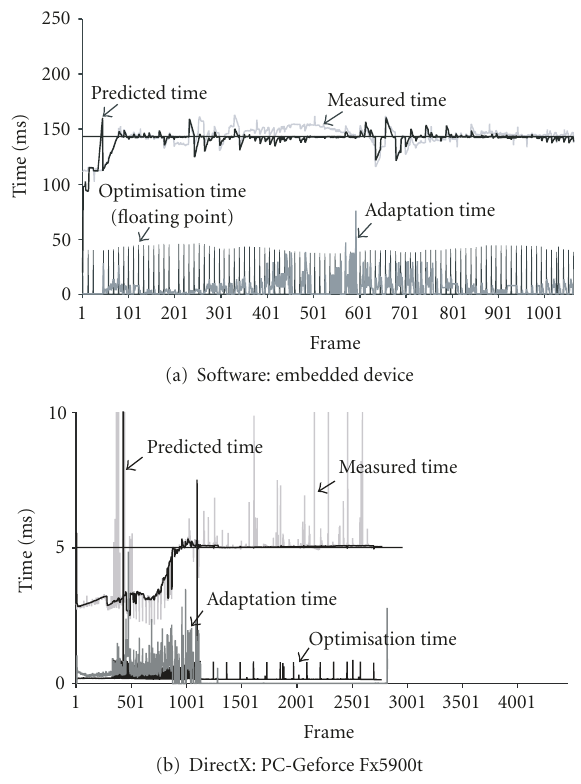
Figure 6: Controlled execution time on two di ff erent platforms for a 3D scene walkthrough with a moving